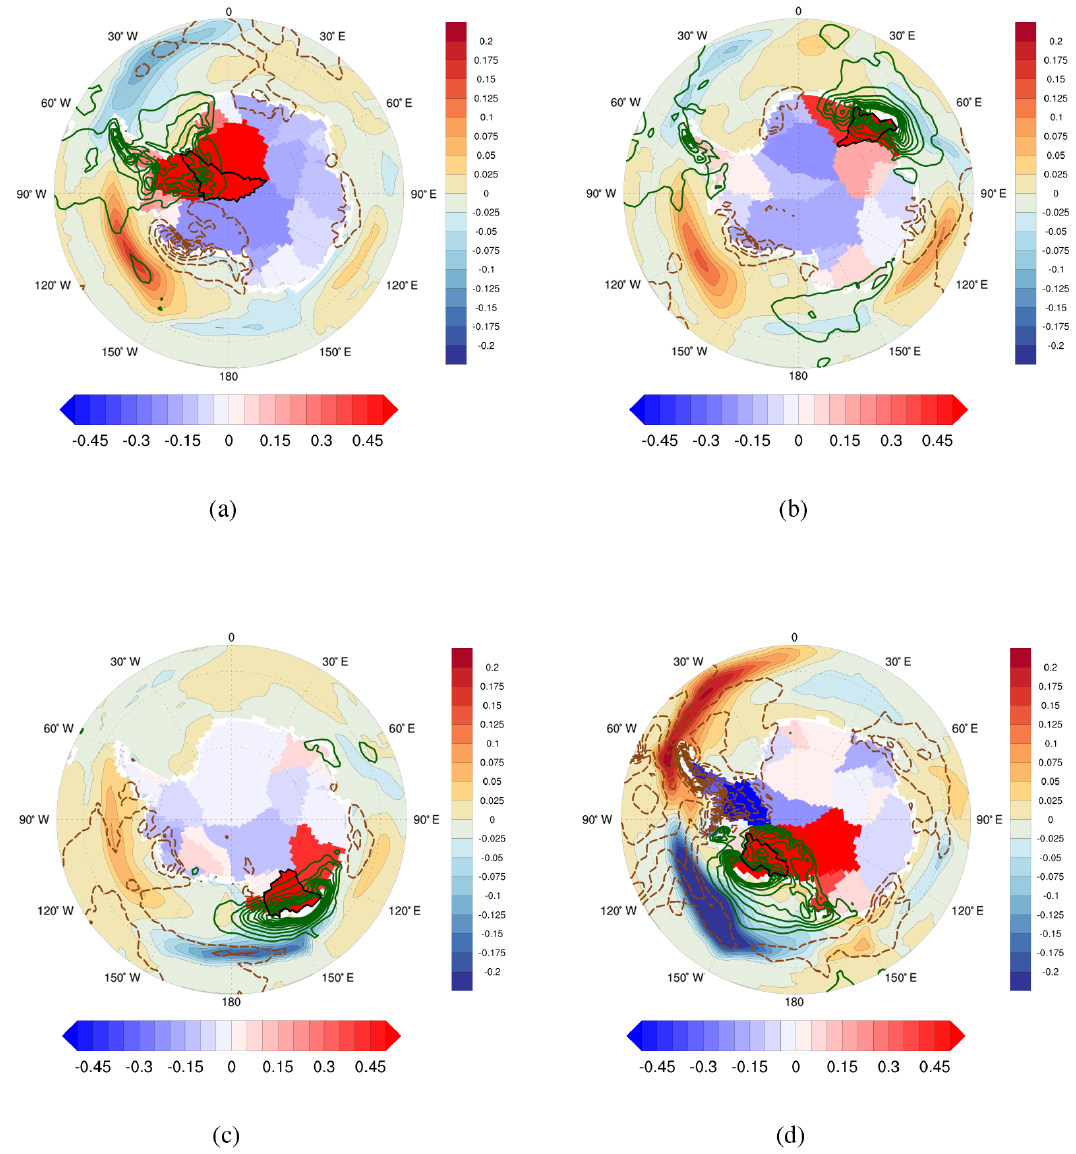
Figure 6. (a–d) Solid shading over ocean areas: composite sea ice concentration climatology differences (vertical color bar, high minus low basin-specific integrated precipitation). Contour lines: composite P − E climatology differences. Positive inter-composite P − E difference colored green; negative inter-composite P − E difference colored brown. Contours at 1mgm − 2 s − 1 intervals, to a minimum/maximum of − 10/10mgm − 2 s − 1 . Basin-specific coloring and basin outlines as in Fig. 4 (horizontal color